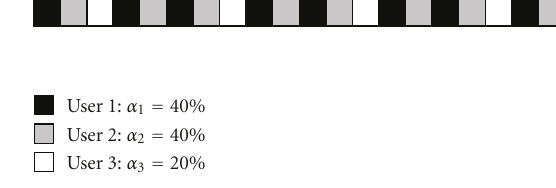
Figure 1: Packet-based generalized processor sharing